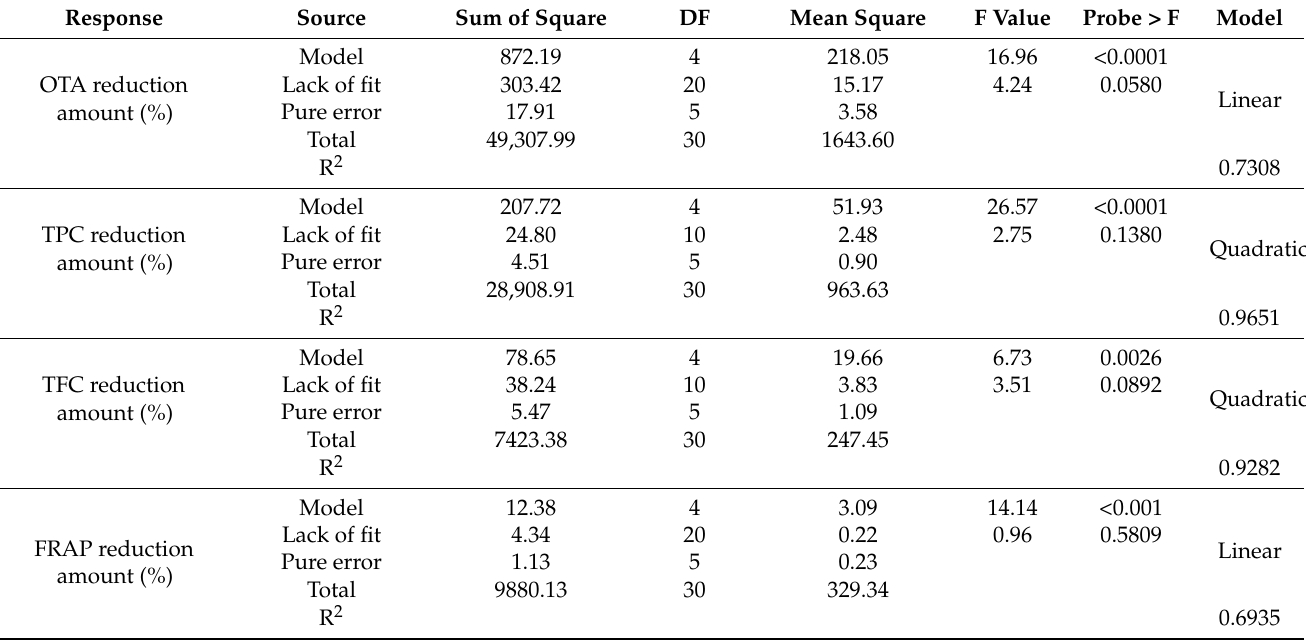
Table 3. ANOVA for responses by response surface method.